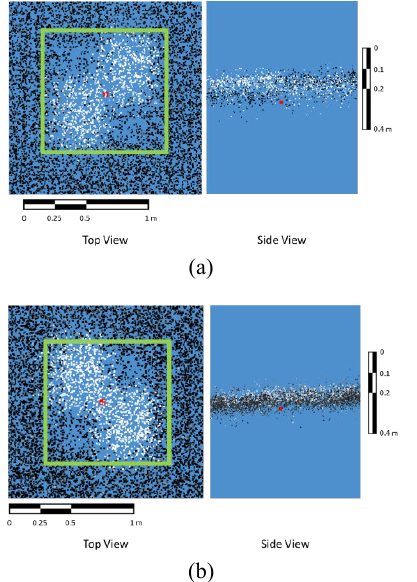
Figure 9. Alignment between LiDAR data (colored by intensity) and RTK-GNSS points (colored in red) of checkerboard targets: (a) Target 3 and (b) Target 9 for A-1 dataset.